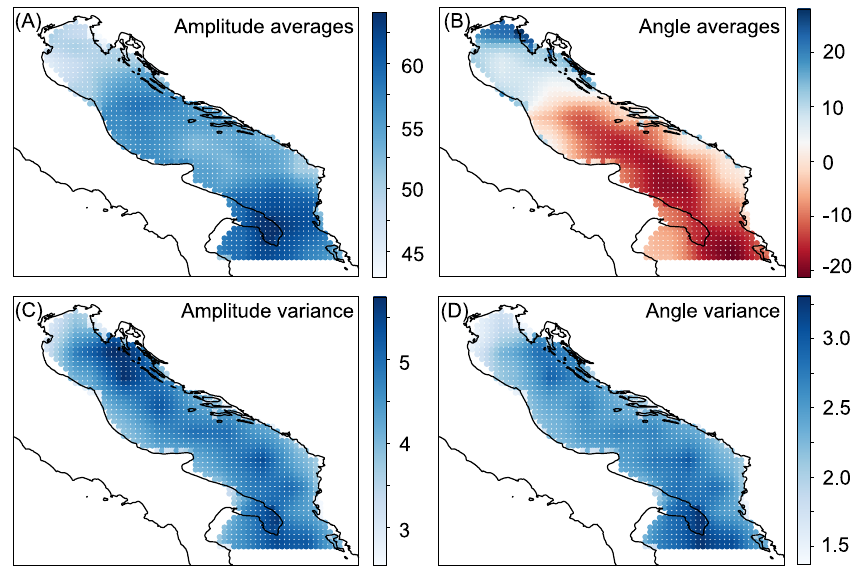
Figure 2. Adriatic sea—Panels show: ( A ) Amplitude average. ( B ) Angle average. ( C ) Amplitude variance. ( D ) Angle